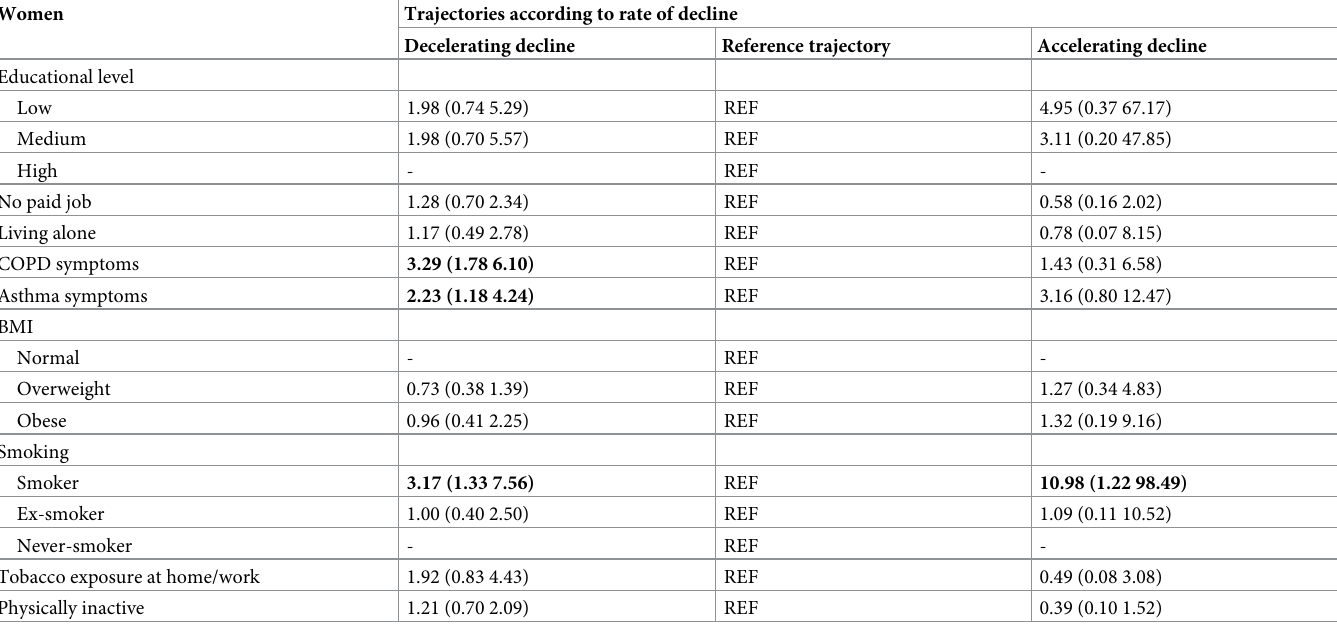
Table 4. Baseline sociodemographic and lifestyle determinants of the trajectories for women compared to the most common FEV 1 trajectory (reference